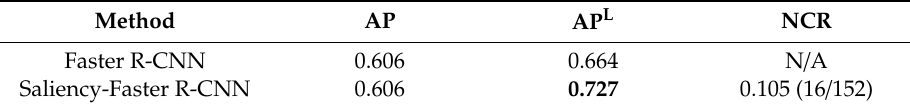
Table 3. Comparison of the Saliency-Faster R-CNN and Faster R-CNN.